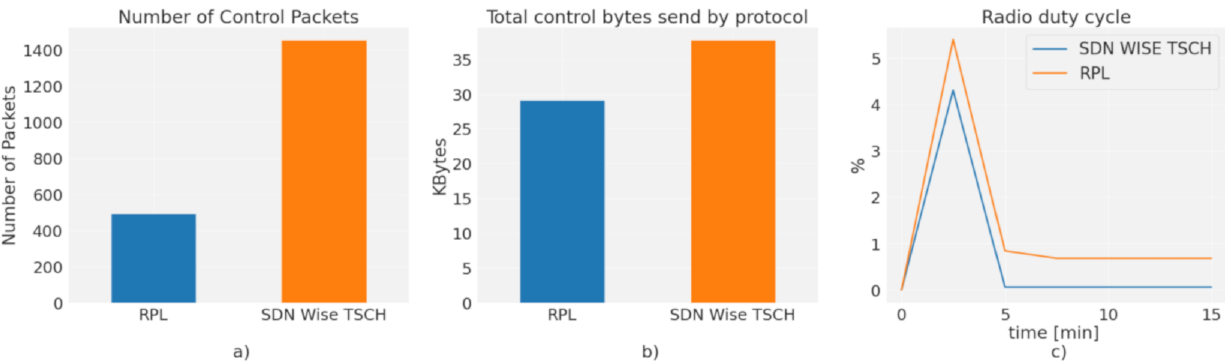
Figure 9. Control traffic generated by Routing Protocol for Low-Power and Lossy Networks (RPL) vs.